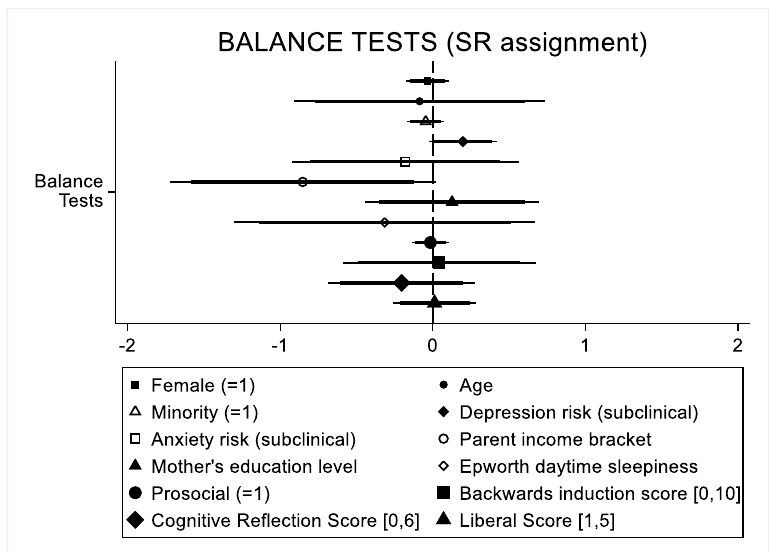
Figure A1. Balance Tests. Notes: Observations = 197. Point estimates represent coefficient estimates, β , on simple regression of variable listed on indicator variable for treatment assignment (SR = 0 or 1): Characteristic = α + β ( SR ) + ε . Thin (thick) lines around point estimates represent the 95% (90%) confidence intervals. Measures assessed in these tests were derived from the recruitment database information.